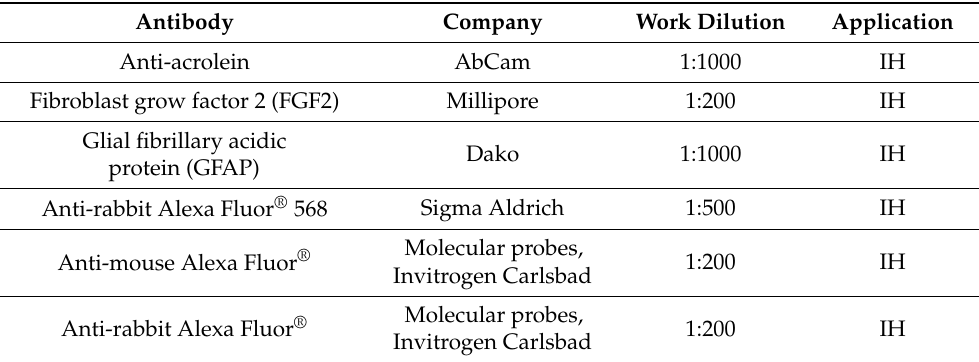
Table 2. List of antibodies for